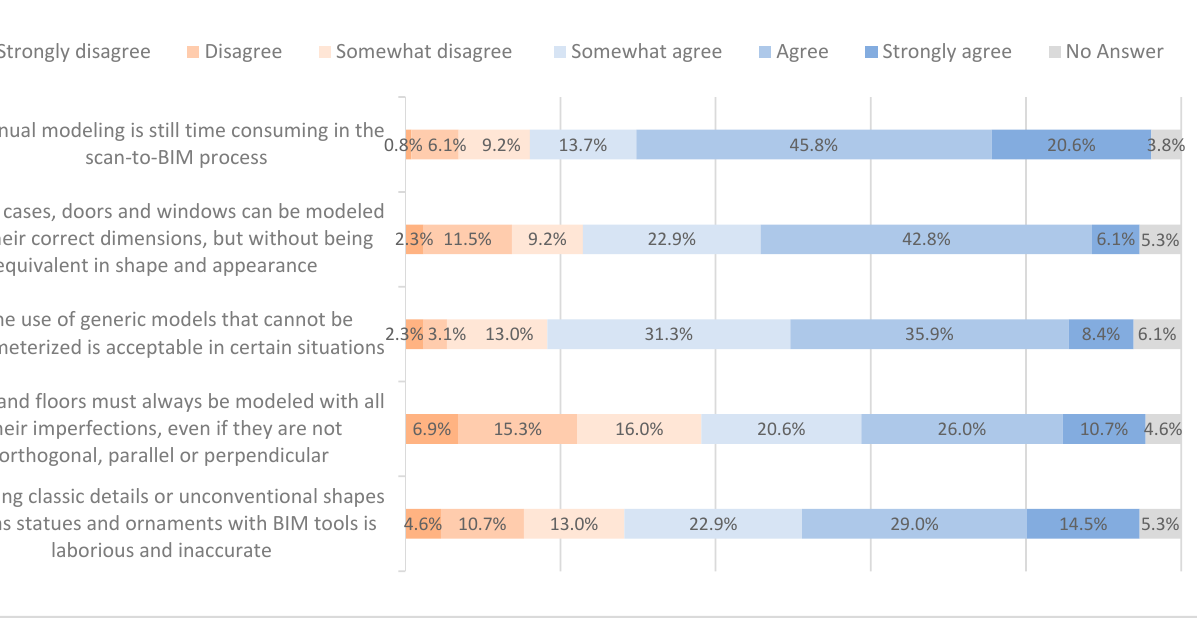
Figure 21. Opinion trend chart for some statements of the scan-to-BIM workflow.